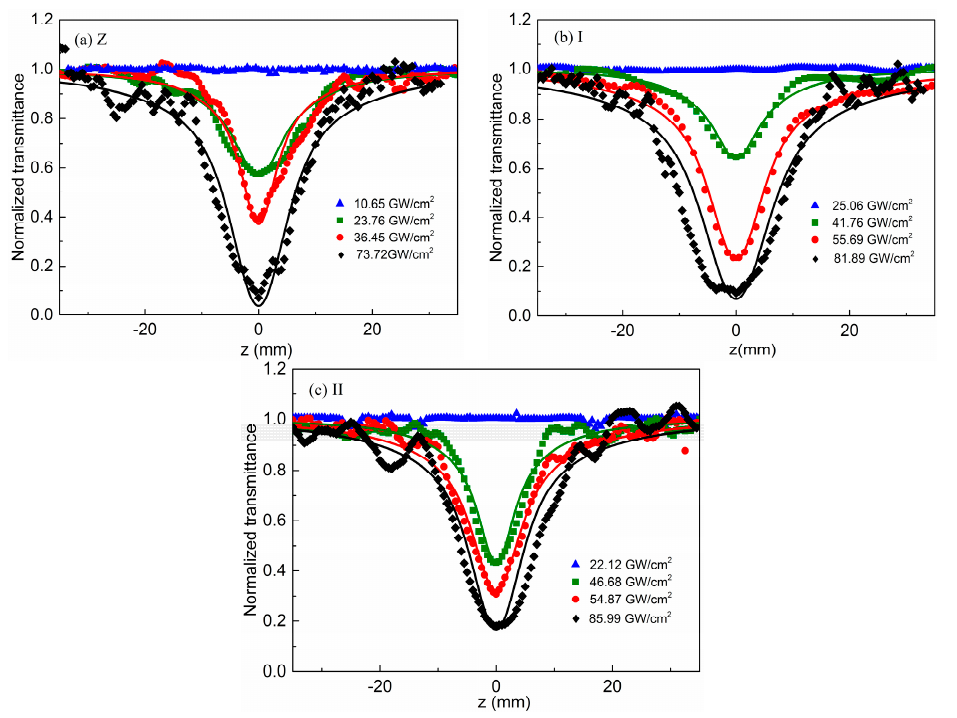
Figure 6. Open aperture Z-scan data and fitted curves for 70%-DKDP samples with different intensities at λ = 532 nm: ( a ) z-direction, ( b ) I-type, ( c ) II-type.